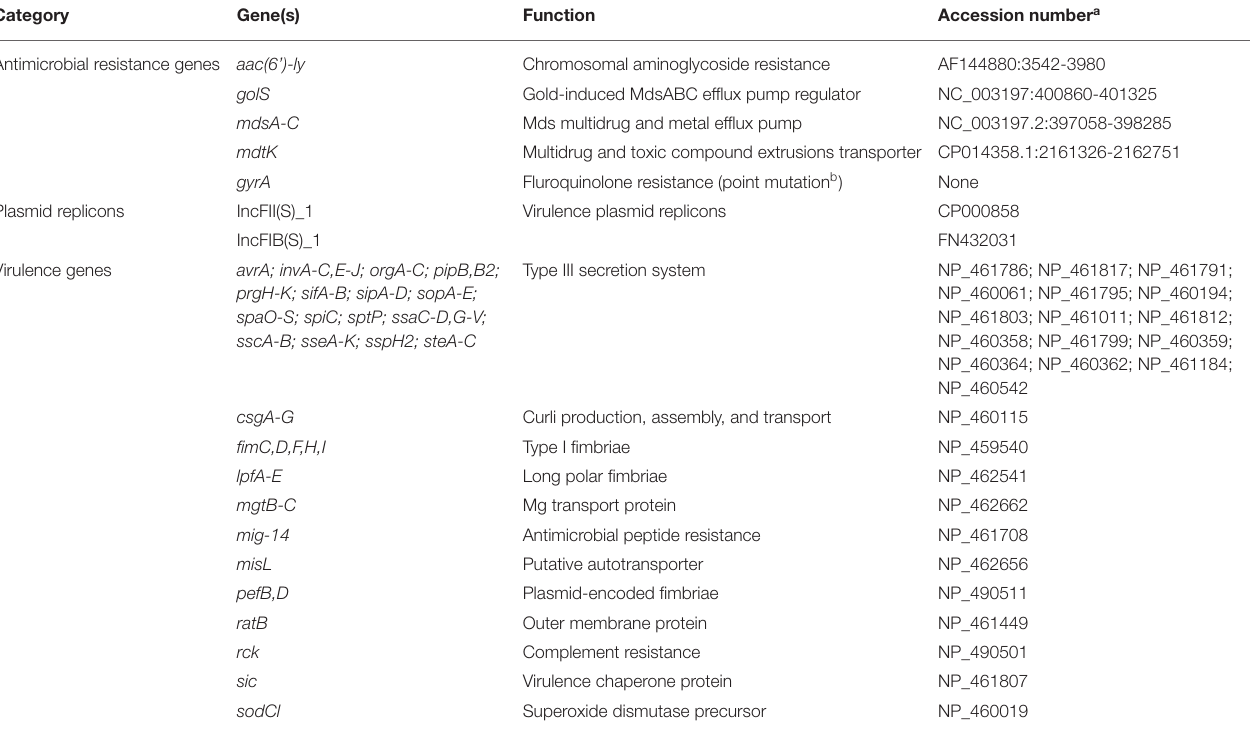
TABLE 1 | Summary of antimicrobial resistance genes, plasmid replicons, and virulence genes detected in the draft genome sequence of Salmonella Enteritidis strain SE_TAU19 using ABRicate.